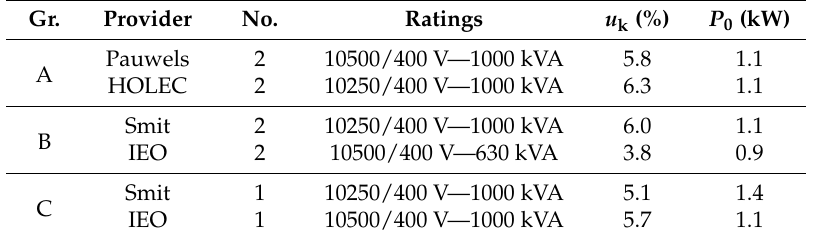
Table 1. Specifications of the transformers used to supply the ArenA stadium from the 10.5 kV grid.